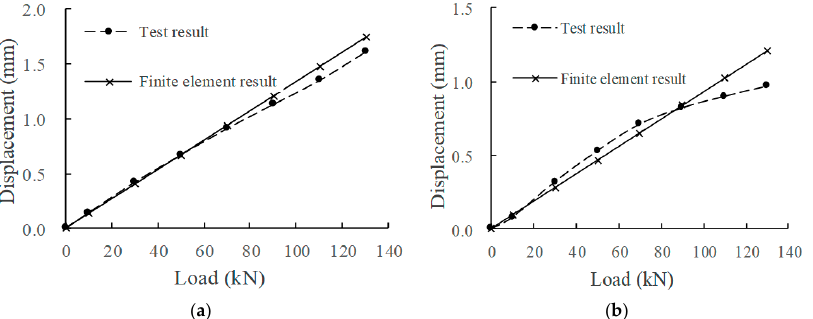
Figure 8. Displacement of rail relative to track slab: ( a ) 0 million times of train load; ( b ) 30 million times of train load.